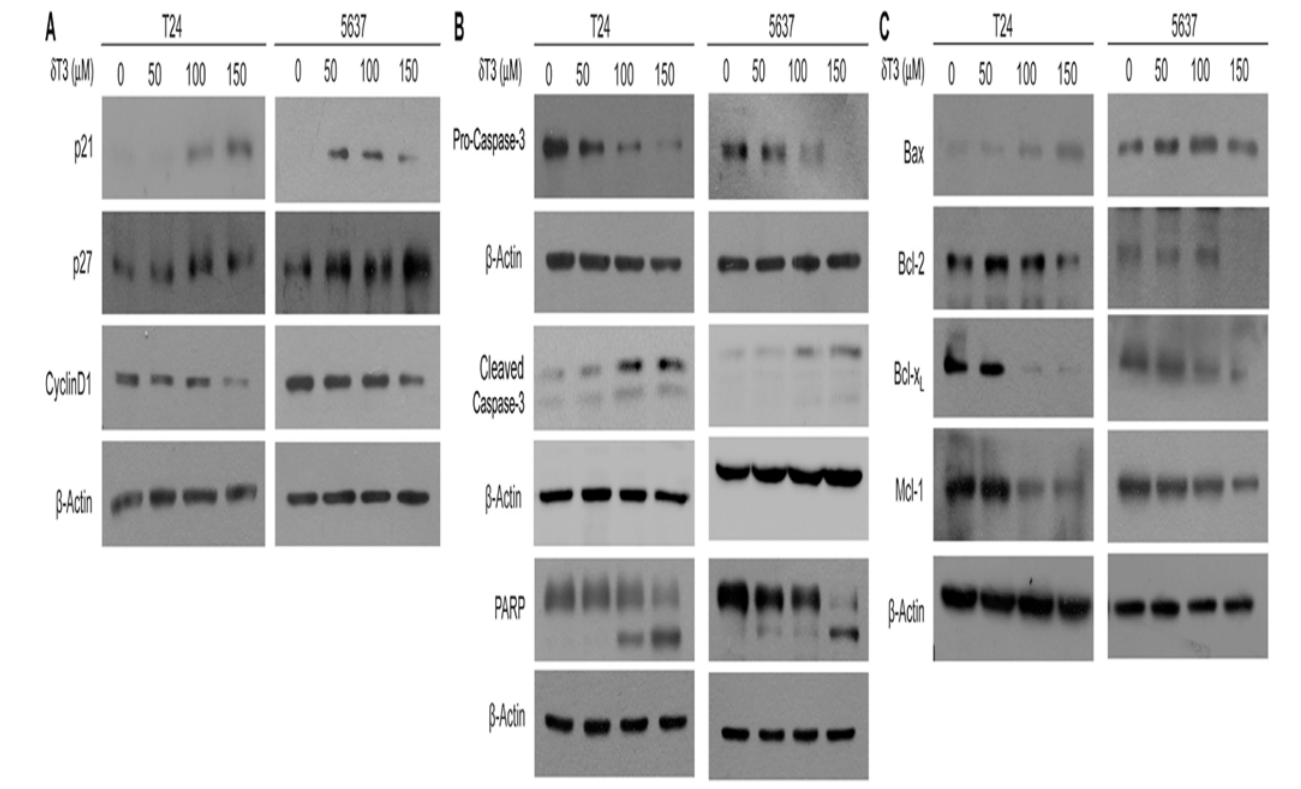
Fig 4. δ -T3 treatment changes protein expression levels involved in cell cycle arrest and apoptosis. Western blotting analysis of the cell cycle (A), apoptosis (B) and other apoptosis-related (C) protein levels in T24 and 5637 cells, upon the δ -T3 treatment for 24 h. β -Actin was used as the loading control.